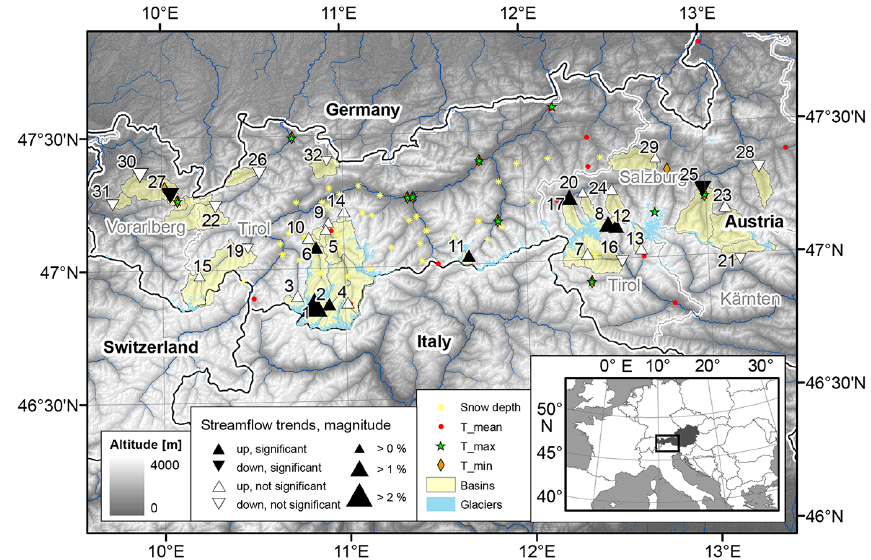
Figure 1. Study area with meteorological stations, watershed boundaries, glaciers and trends of mean annual streamflow in percent change per year (period: 1980–2010; significance level: α = 0.1). Station ID next to the